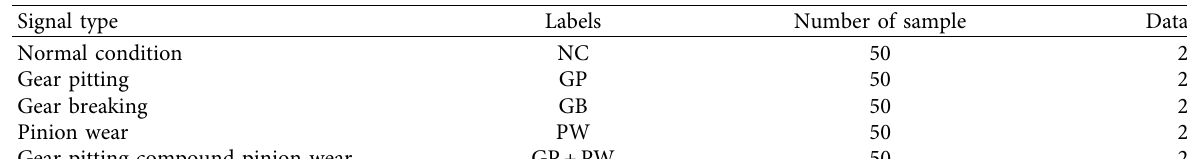
Table 5: Experimental sample description of the gearbox.